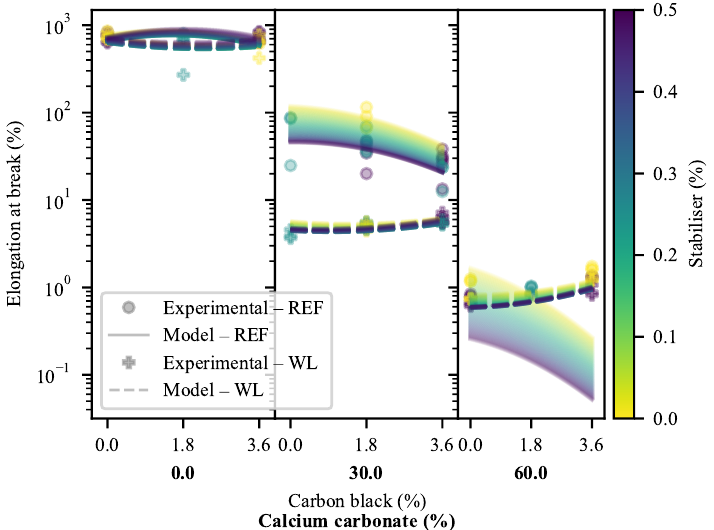
Figure 14. Change in elongation at break, as a function of the loadings of calcium carbonate, carbon black and the stabiliser package. Note the quality of fit of the models, with the clear exception of the REF model at the 60-CC level. Note also the step and contrasting slopes between the WL and REF cases at the 30-CC